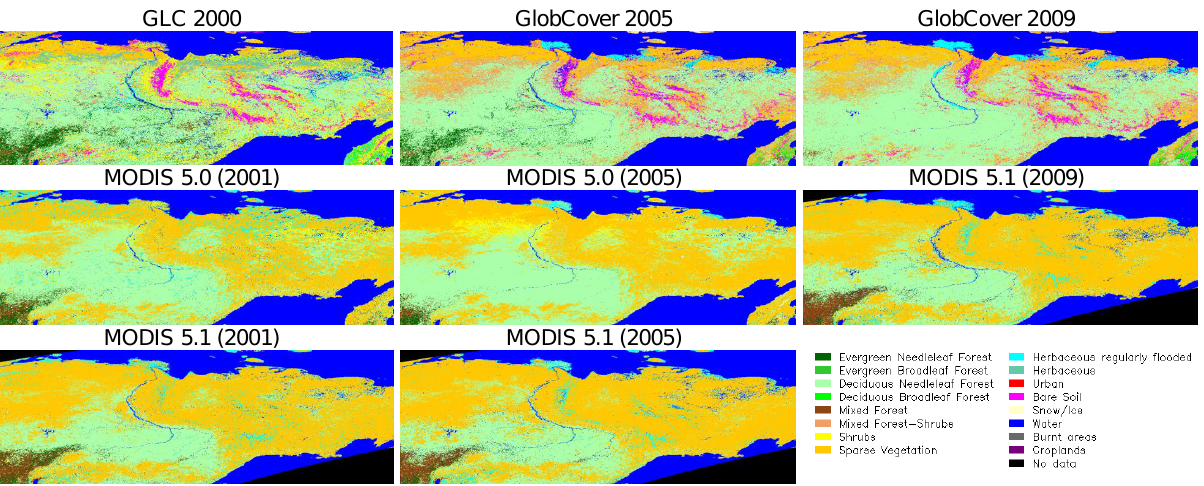
Figure 1. Comparison of five land cover products in Yakutia: GLC2000, GlobCover 2005 and 2009, MODIS 5.0 and 5.1 for 2001, 2005 and 2009, aggregated at 1km scale to a common legend. Table 4. Fraction of each class in each product for Yakutia, values larger than 0.1 appear in